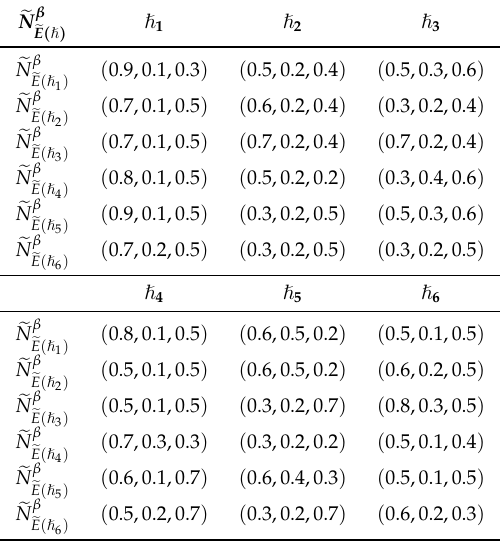
Table 5. A tabular representation of FOF β -neighborhood.